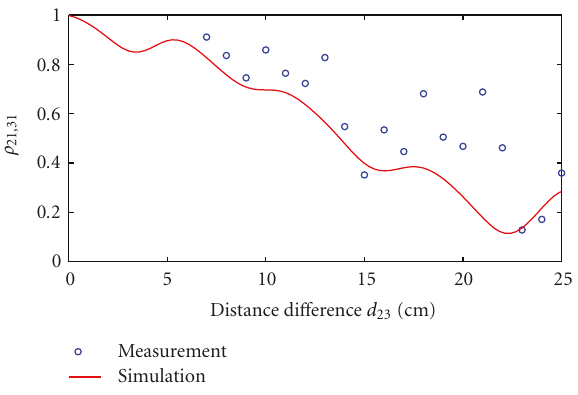
Figure 12: Comparison of the channel fading amplitude (dB) correlation coe ffi cient, ρ 21,31 for normal polarization scenarios around the trunk with d 10 = 12 cm and d 12 = 7cm.